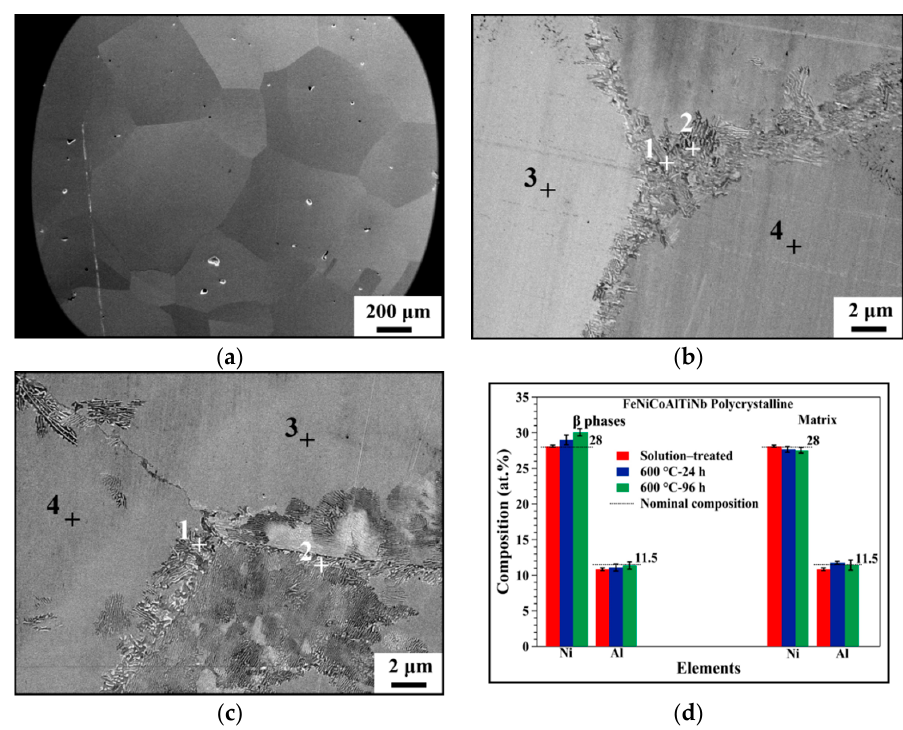
Figure 2. Backscattered electron micrograph of the FeNiCoAlTiNb polycrystalline alloy: ( a ) solution-treated sample, ( b ) 600 °C—24 h, ( c ) 600 °C—96 h, and ( d ) comparison of composition analysis results of matrix and β phases based on Tables 1 and 2. EDS average analysis results. Table 1. The composition measurements of the FeNiCoAlTiNb alloy after 600 °C—24 h. Element